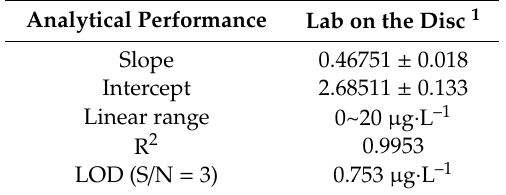
Figure S1: Influence of NaClO4 on the solubility of [OPy] + [BF4]– in water at room temperature, Figure S2: The fluorescence (FL) intensity of 10 µ M PTR and 10 µ M mercury solutions with 25% ionic liquid, water fraction of 70%, in water bath (55 ◦ C), Figure S3: The fluorescence (FL) intensity at 589.2 nm under di ff erent excitation